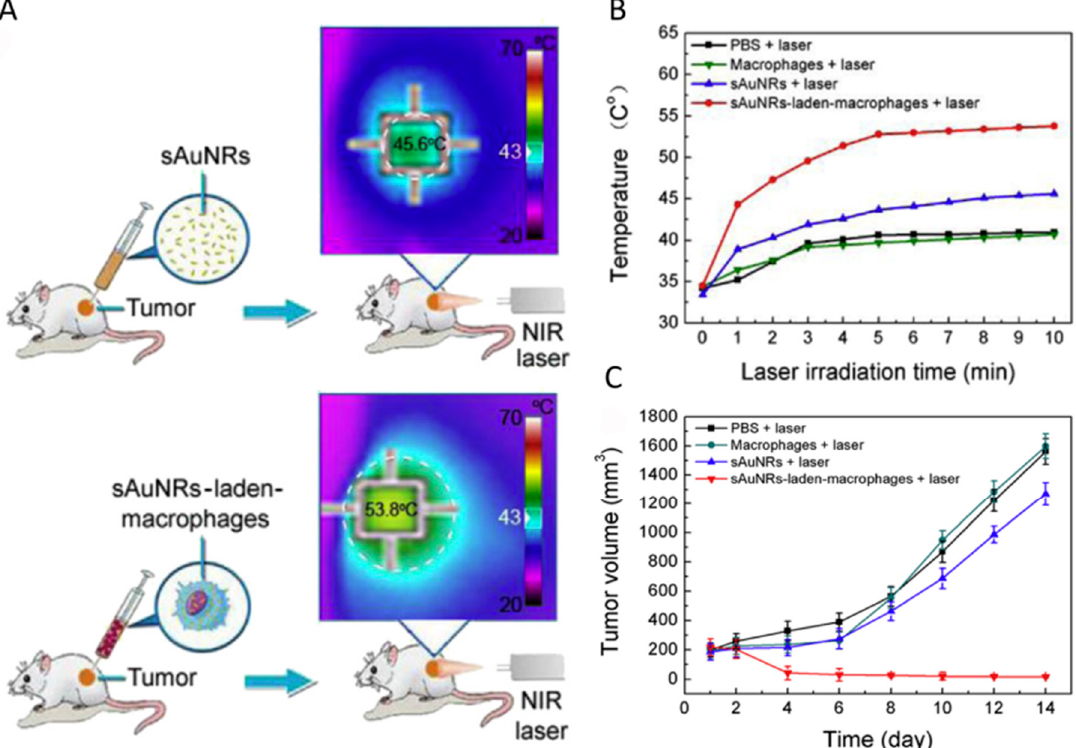
Figure 12. ( A ) Diagram highlighting the difference between the treatment of free small gold nanorods and macrophage-loaded small gold nanorods; ( B ) temperature profile of tumor under 808 nm light irradiation for 10 min; and ( C ) growth of tumors in the different groups of mice after the irradiation treatments [99].